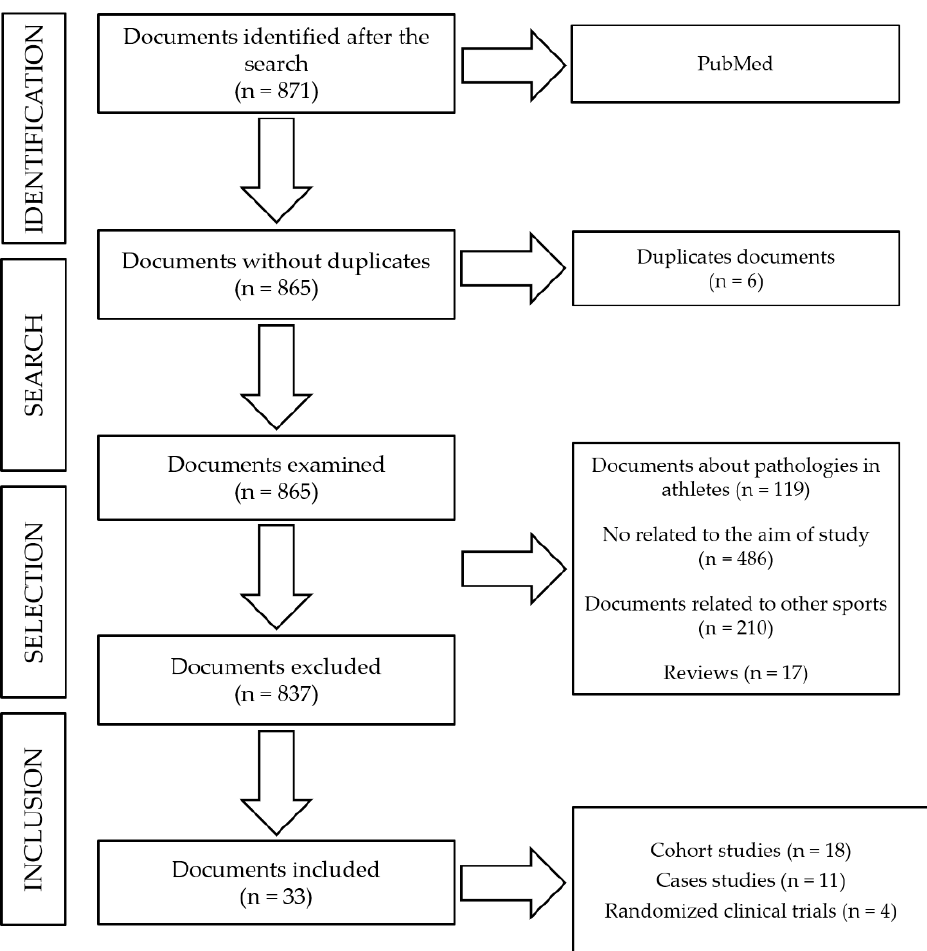
Figure 1. Flow diagram showing the process used to select the studies.